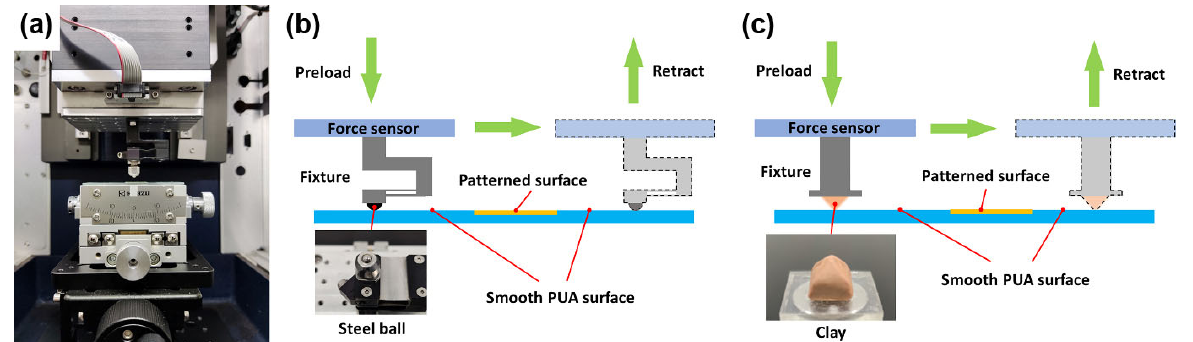
Fig. 3 (a) Optical image of the test platform and the relative parallel movement regulated by the angled table (SA07A-RT, KOHZU, Japan); (b, c) schematic illustration of frictional measurement procedures with smooth steel ball and commercial clay, respectively, where the size of the patterned surface was limited in the middle of samples, and the green arrows indicate the movement direction of